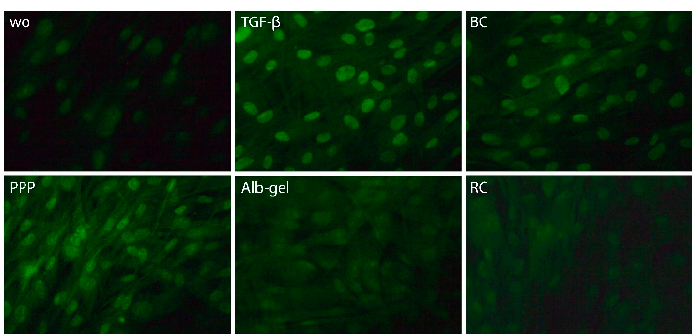
Figure 5. Lysates of PPP and the buffy coat layer but not heated PPP provoked nuclear translocation of Smad2/3. Gingival fibroblasts were exposed for 1 h to 30% of the lysates prepared from PPP, heated PPP (75 °C for 10 min, Alb-gel), and buffy coat (BC). For red clot, 5% of the lysates was used. Immunofluorescence revealed the nuclear translocation of Smas2/3 by lysates prepared from PPP and the buffy coat (BC) but not when cells were exposed to lysates of heated PPP and red clot.